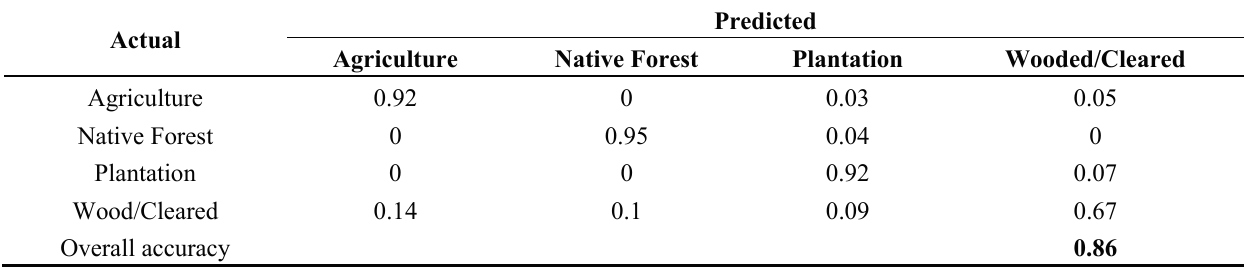
Table 2. Summary of accuracy of classification predicted by